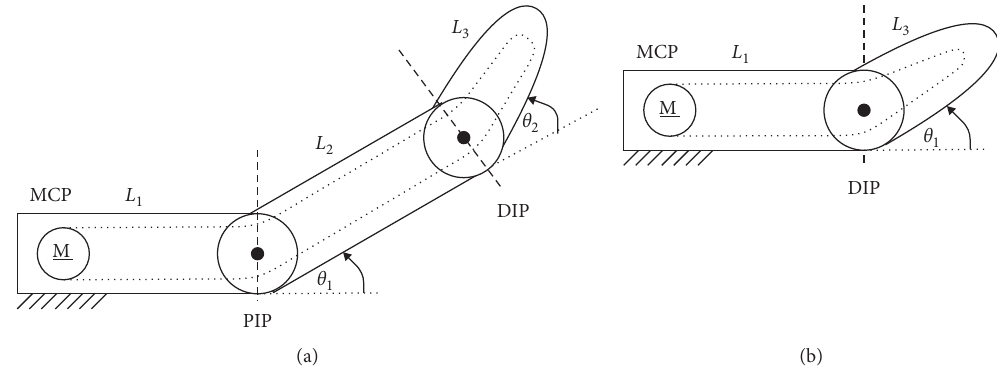
Figure 6: Architecture of the finger model of the robot hand: (a) index and middle finger; (b) thumb finger.